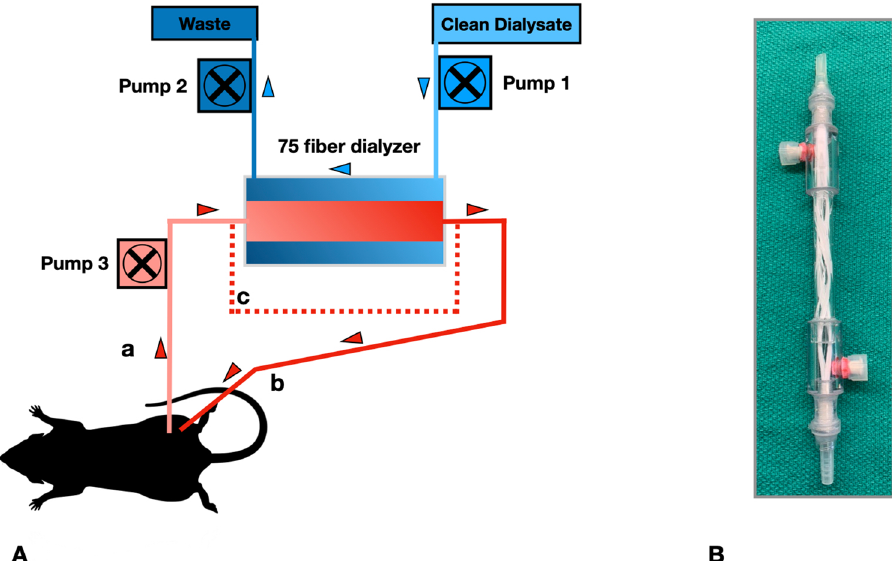
Figure 1. Dialysis setup and mini-dialyzer. ( A ) Schematic overview of dialysis setup. a: catheter left femoral artery, b: catheter left femoral vein, c: the bypass shunt used for sham procedure. Blood pumps, 1 & 2 dialysate pumps. Blood is pumped (pump 3) from the femoral artery through the dialysis unit to the tail vein, while dialysate is counter-currently pumped through the dialysis-unit. Blood flow is set at 2 ml/min/kg body weight, dialysate flow 1 ml/min. ( B ) 75 fiber dialyzer unit (for details see Table 1) (image produced by B(GH)